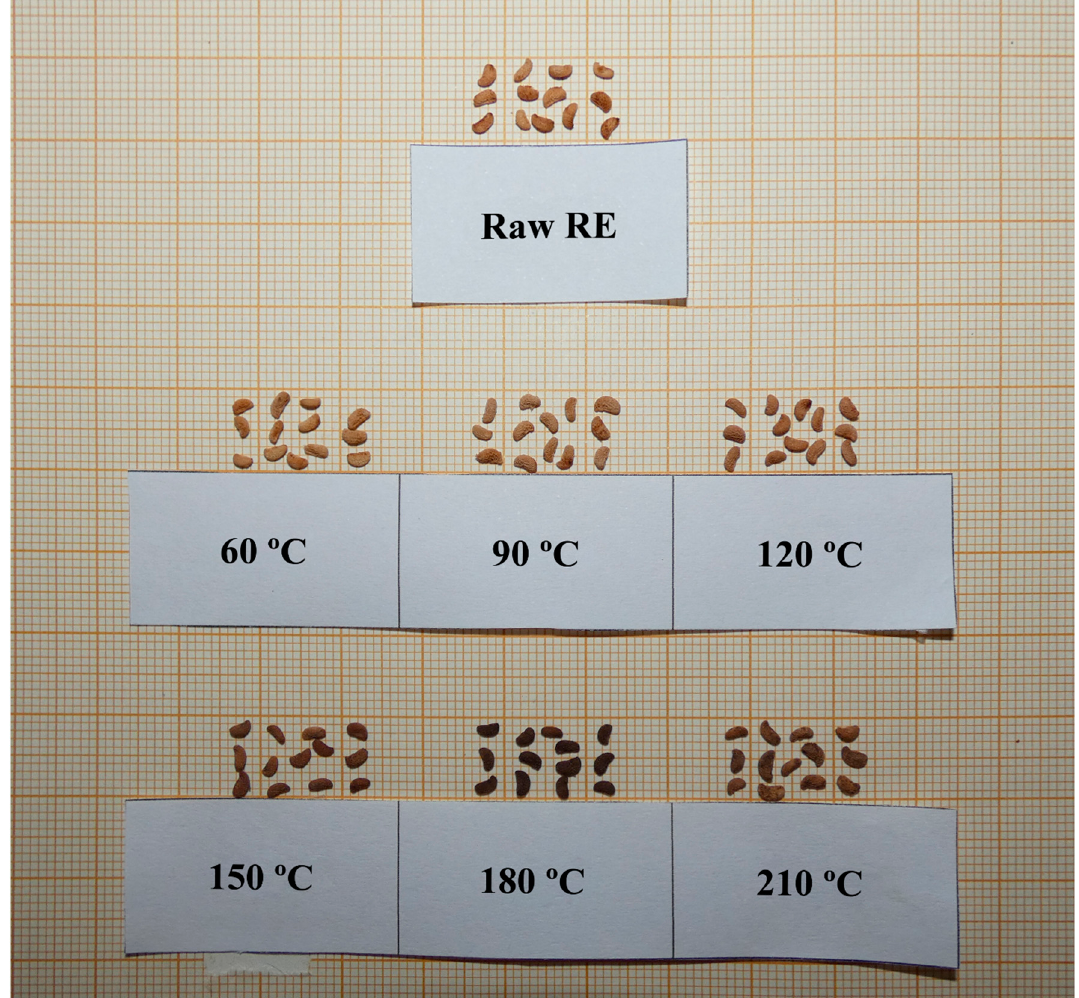
Figure 5. Achenes present in the untreated RE and in the different SPs obtained after each hydrothermal treatment (a graph paper with a 1 mm scale has been used as a photographic background).